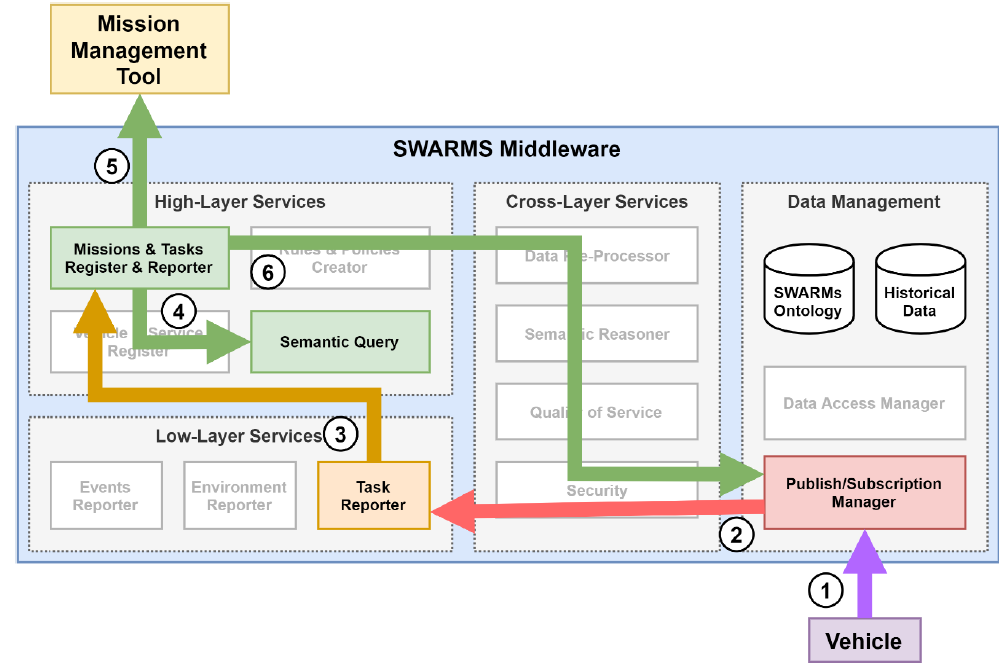
Figure 15. Functional overview of the processing of a mission status report from a vehicle.